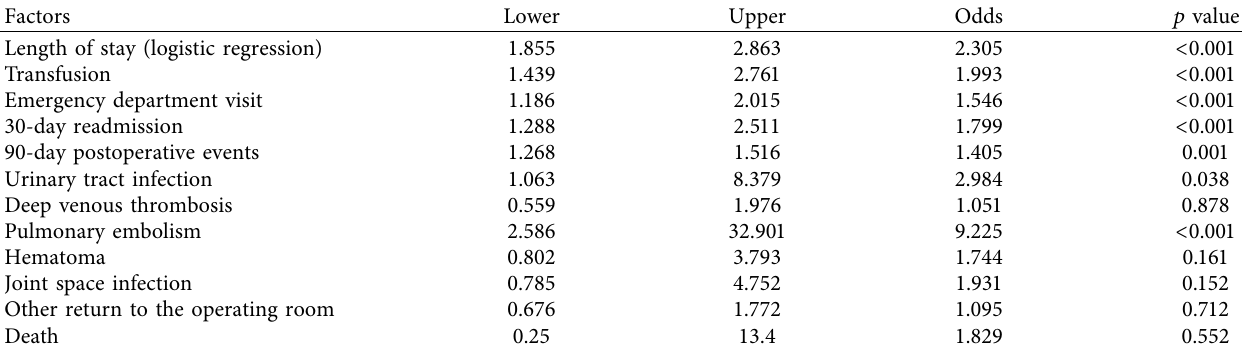
Table 3: Multivariate analysis of 2 or more venous thromboembolism medications